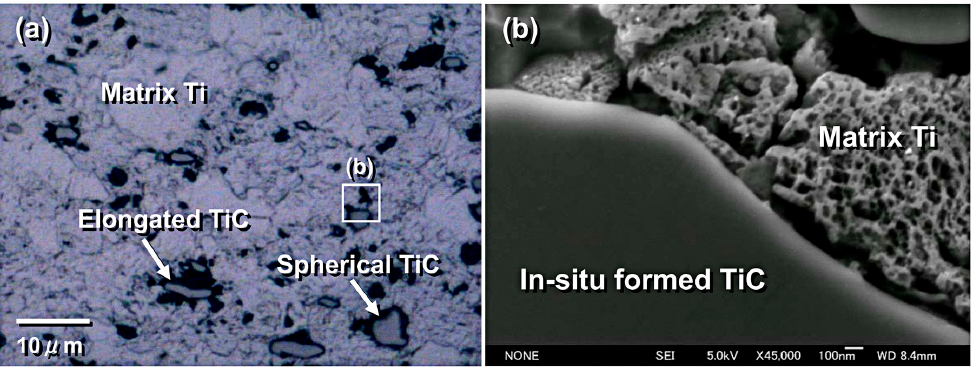
Figure 18. Extruded CNT-dispersed metal matrix nanocomposites: ( a ) Optical image of the binary systems and ( b ) SEM image of TiC/Ti interface [140]. (Reproduced with permission from [140], Elsevier, 2009.)